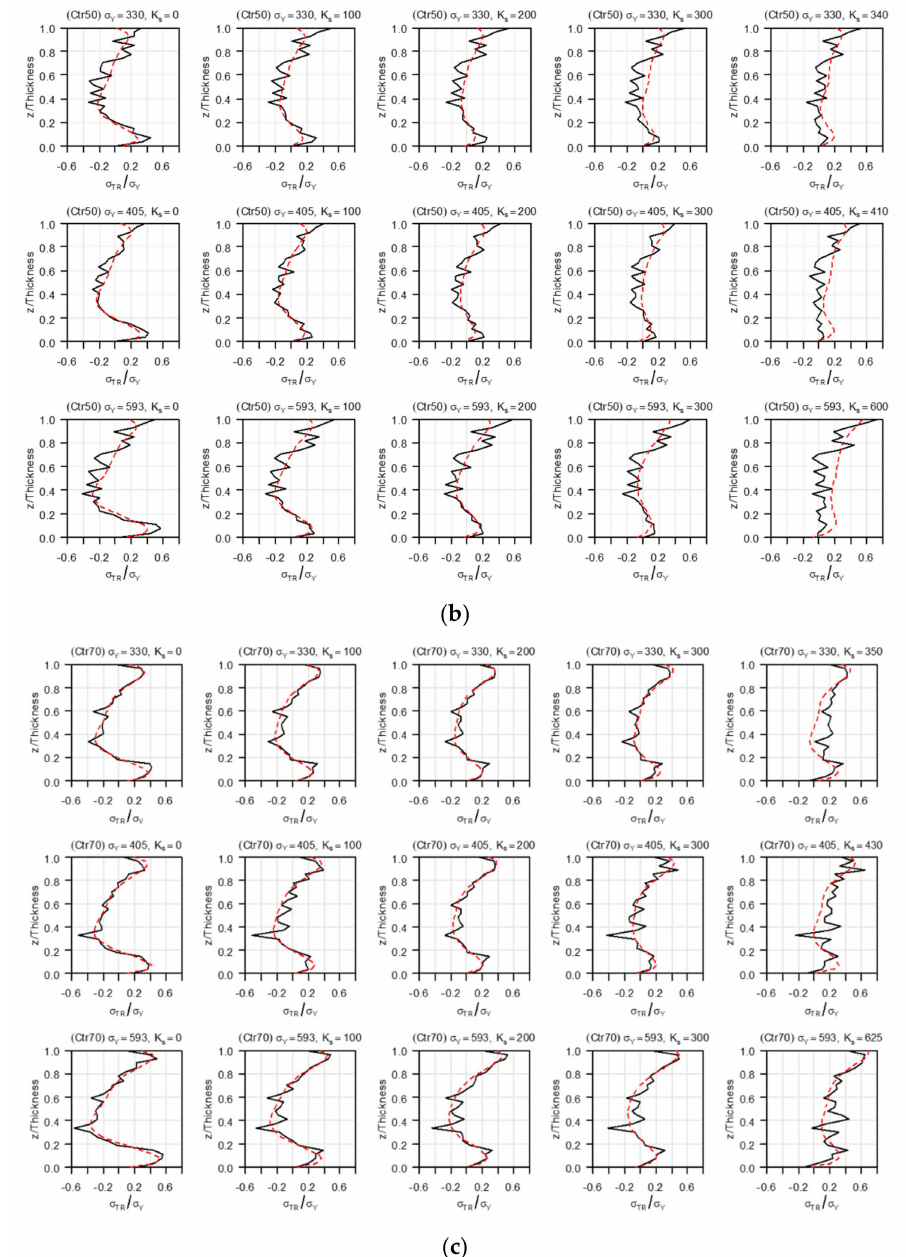
Figure 19. Comparison of analysis and prediction results at the welding center (black solid line: analysis results; red dotted line: prediction results). ( a ) B = 25 mm; ( b ) B = 50 mm; and ( c ) B = 70